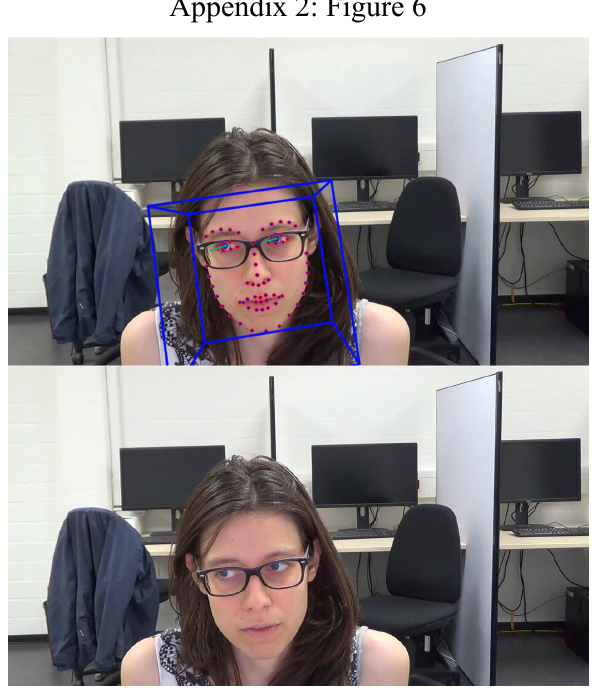
Figure 6: Example of the consistent underestimation of gaze angles on the part of OpenFace. Top: Visual output of OpenFace including the vectors estimating the participant’s gaze angle. Bottom: original video footage. In this case, while human observers rate the participant’s gaze angle as ‘4’, the OpenFace gaze vectors are oriented in a direction corresponding to